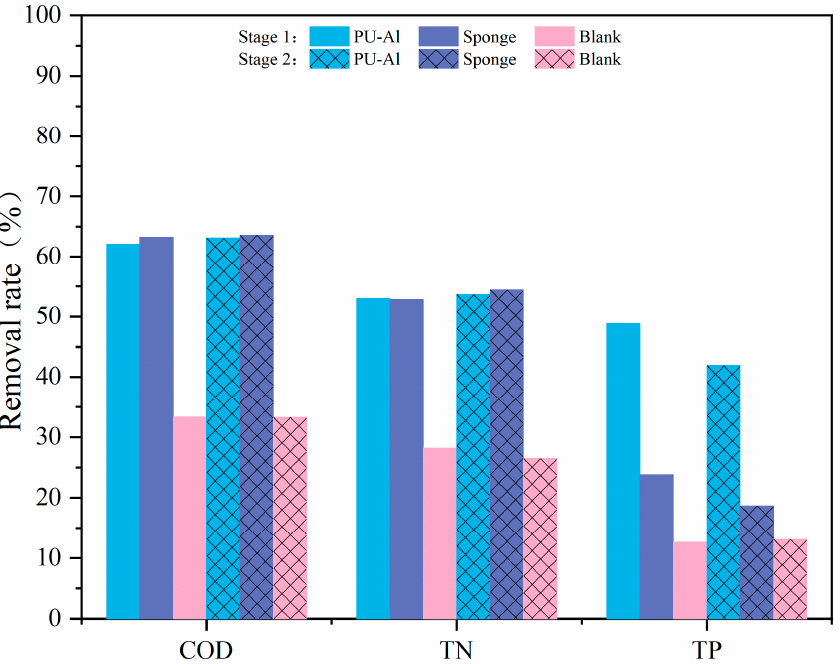
Figure 6. Overall removal performance.